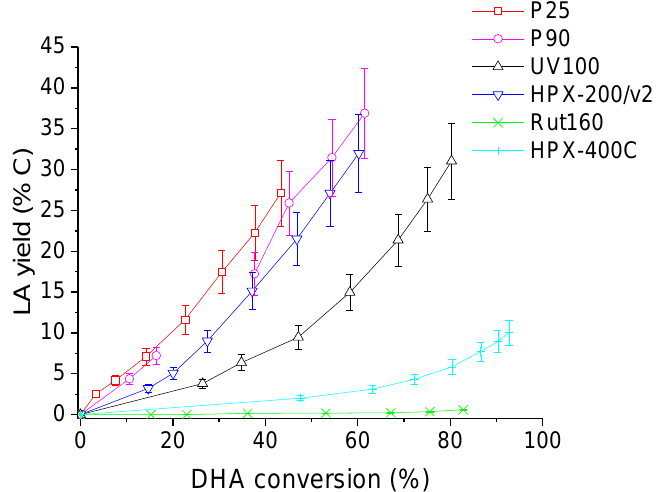
Figure 11. Evolution of lactic acid (LA) yield with DHA conversion in the presence of the six TiO 2 . Conditions: T = 90 °C, P air = 1 atm, V water = 200 mL, (DHA) = 0.1 mol.L − 1 , (TiO 2 ) = 10 g.L − 1 .